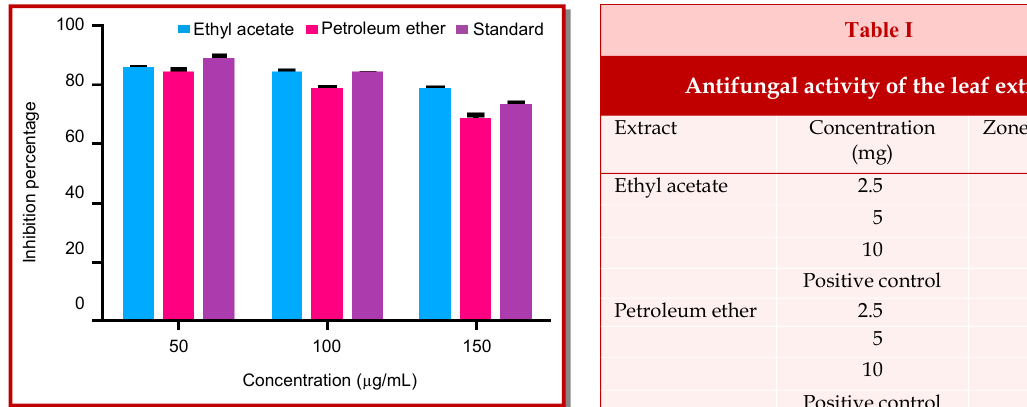
Figure 1: In vitro anti-inflammatory activity of the crude ex- tracts by showing the inhibition of albumin saturation Petrole- Ethyl um acetate